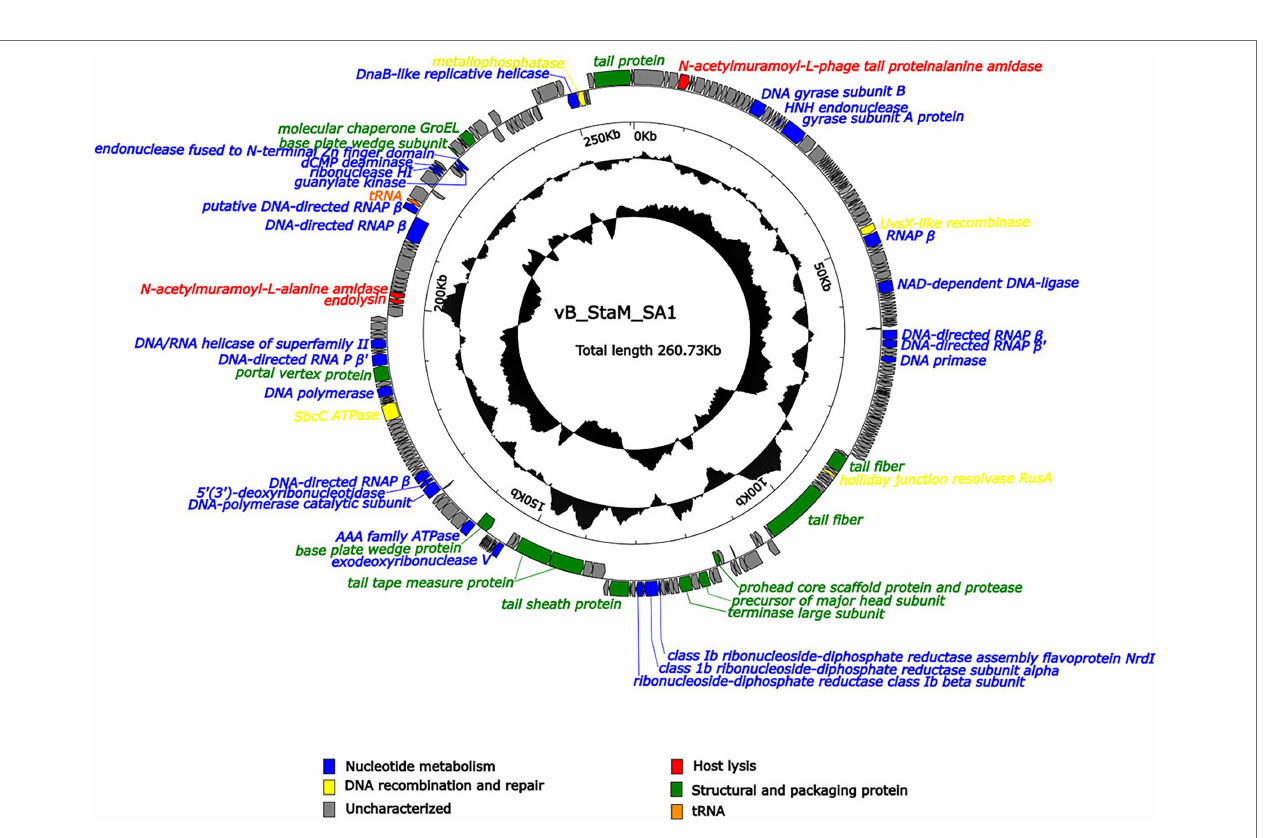
FIGURE 4 | Arrangement of functional genes in the genome of phage SA1. The arrow represents the direction of transcription. Genes with different functions are represented in different